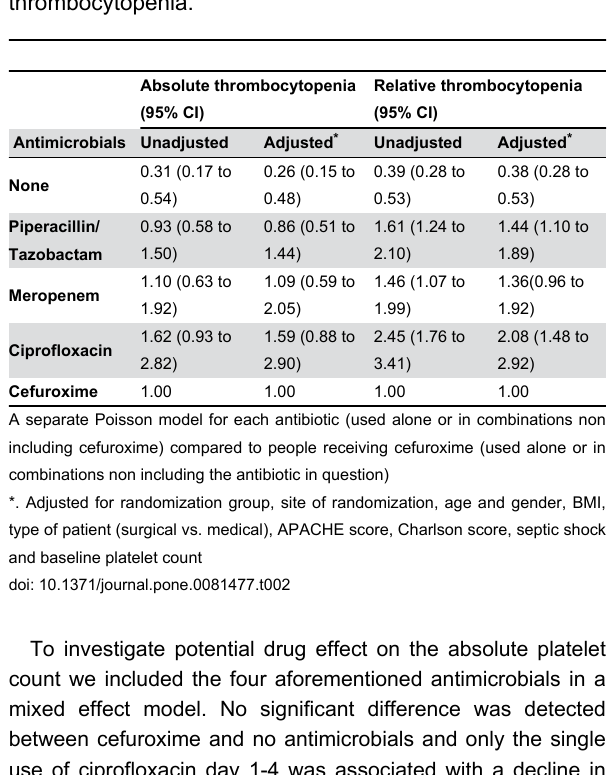
2. Rate Ratio of absolute and relative